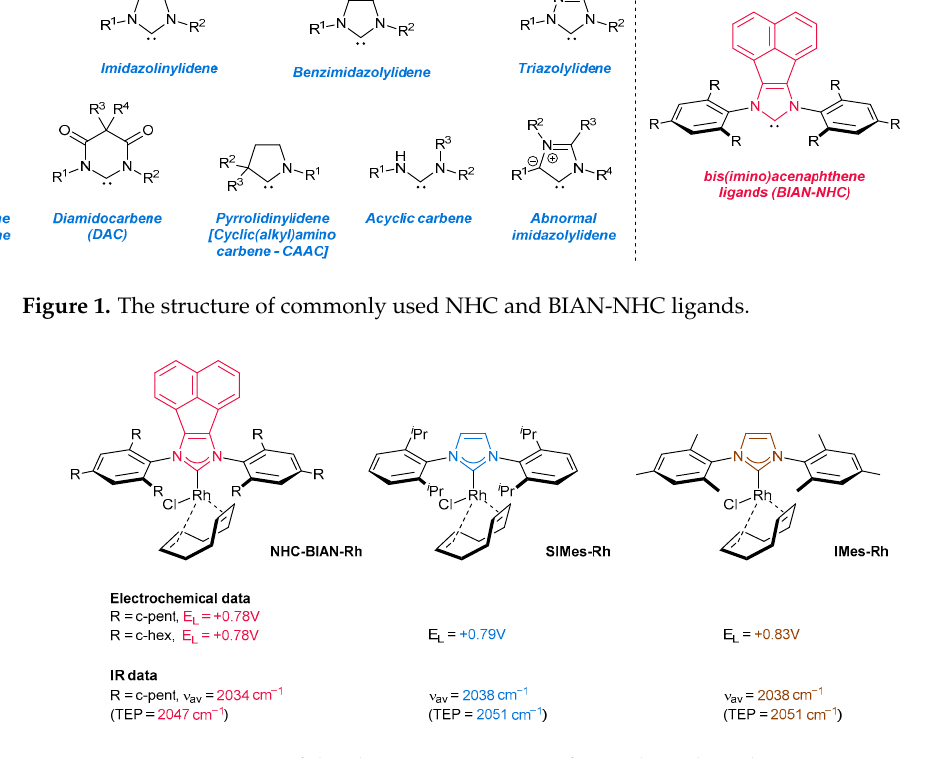
Figure 2. Comparison of the electronic properties of NHC ligands with NHC-BIAN-type one. Apart from the electronic properties, steric effects seem to add to the excellent reactivity of NHC-BIAN-type ligands in catalysis. This could be attributed to the “buttressing effect” of the acenaphthylene backbone [19]. The close proximity of the rigid polyaromatic skeleton would seem to push the N-aryl substituent closer to the metallic center, enabling better control of the catalytic pocket under homogenous conditions. Unfortunately, careful analysis of the available crystallographic data of the metal